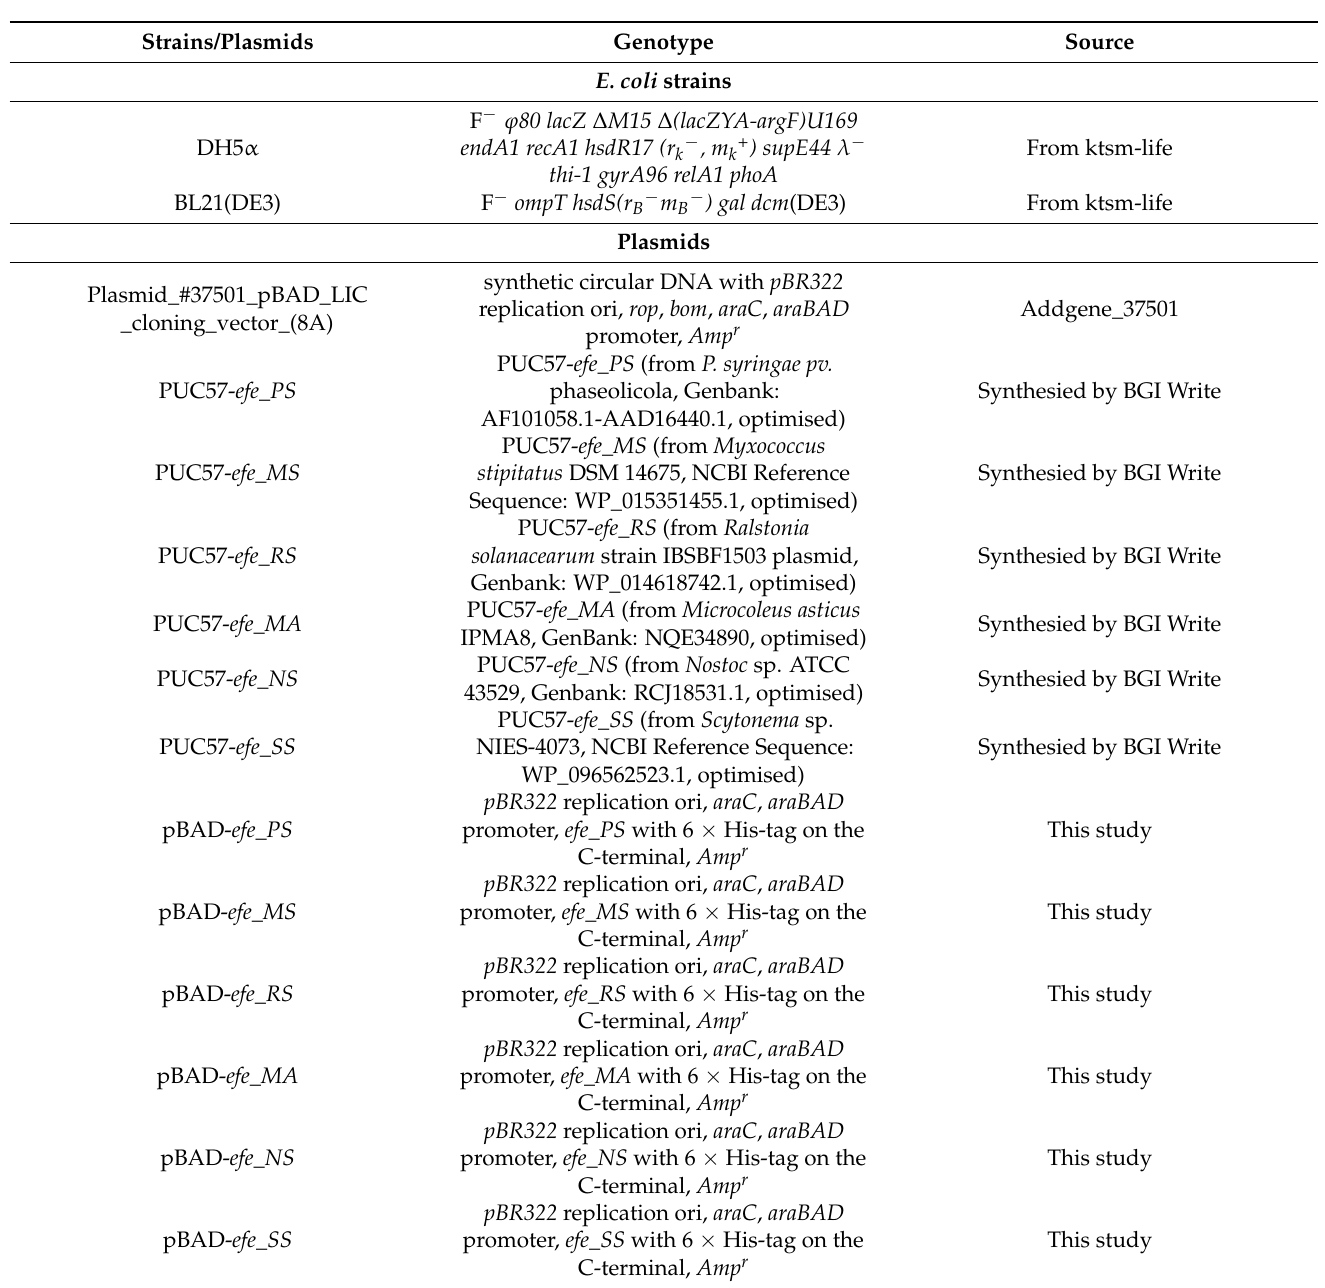
Table 3. E. coli strains and plasmids used in this